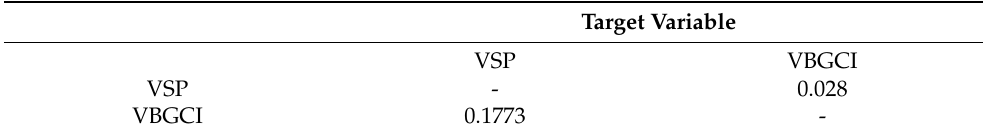
Table 6. Feature importance on